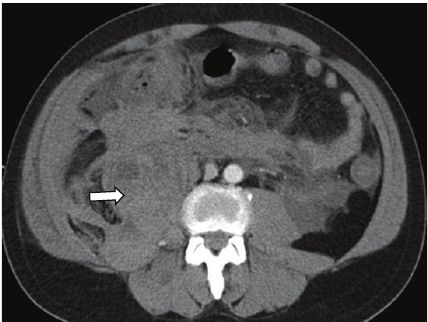
Figure 4: Stat CT abdomen/pelvis. Interval development of a large retroperitonealhemorrhagecenteredaroundtherightpsoasmuscle, with extension to the right spinous erector and iliacus musculature (see